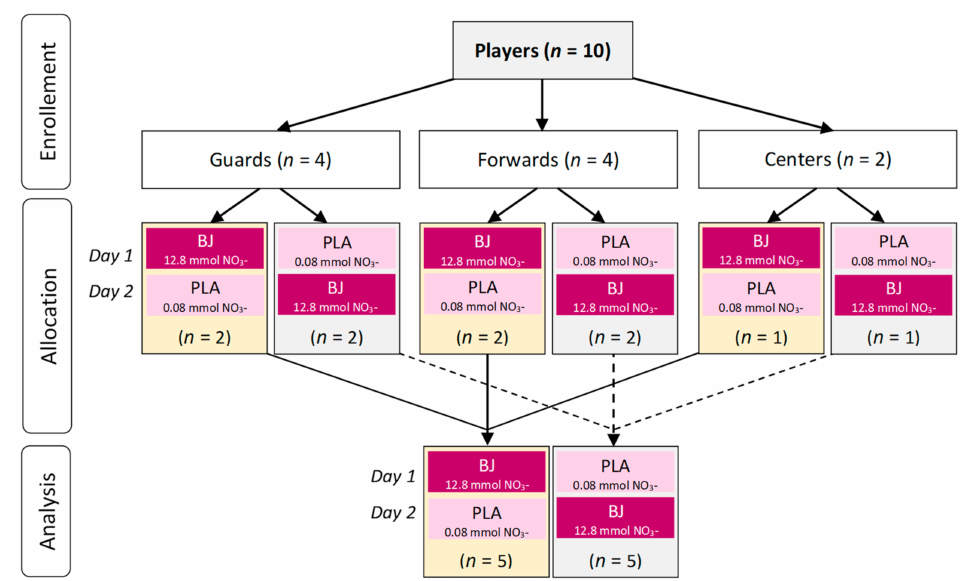
Figure 2. Participant allocation according to beetroot juice (BJ) or placebo (PLA)